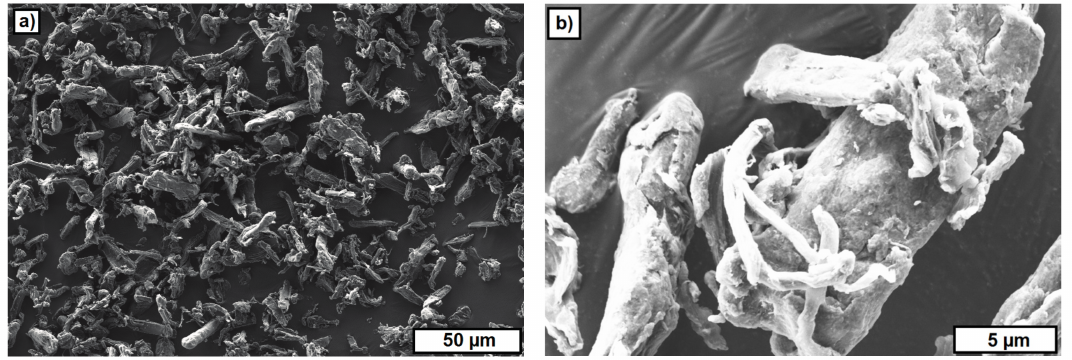
Figure 10. FESEM images of ARBOCEL UFC100. ( a ) Overview; ( b )